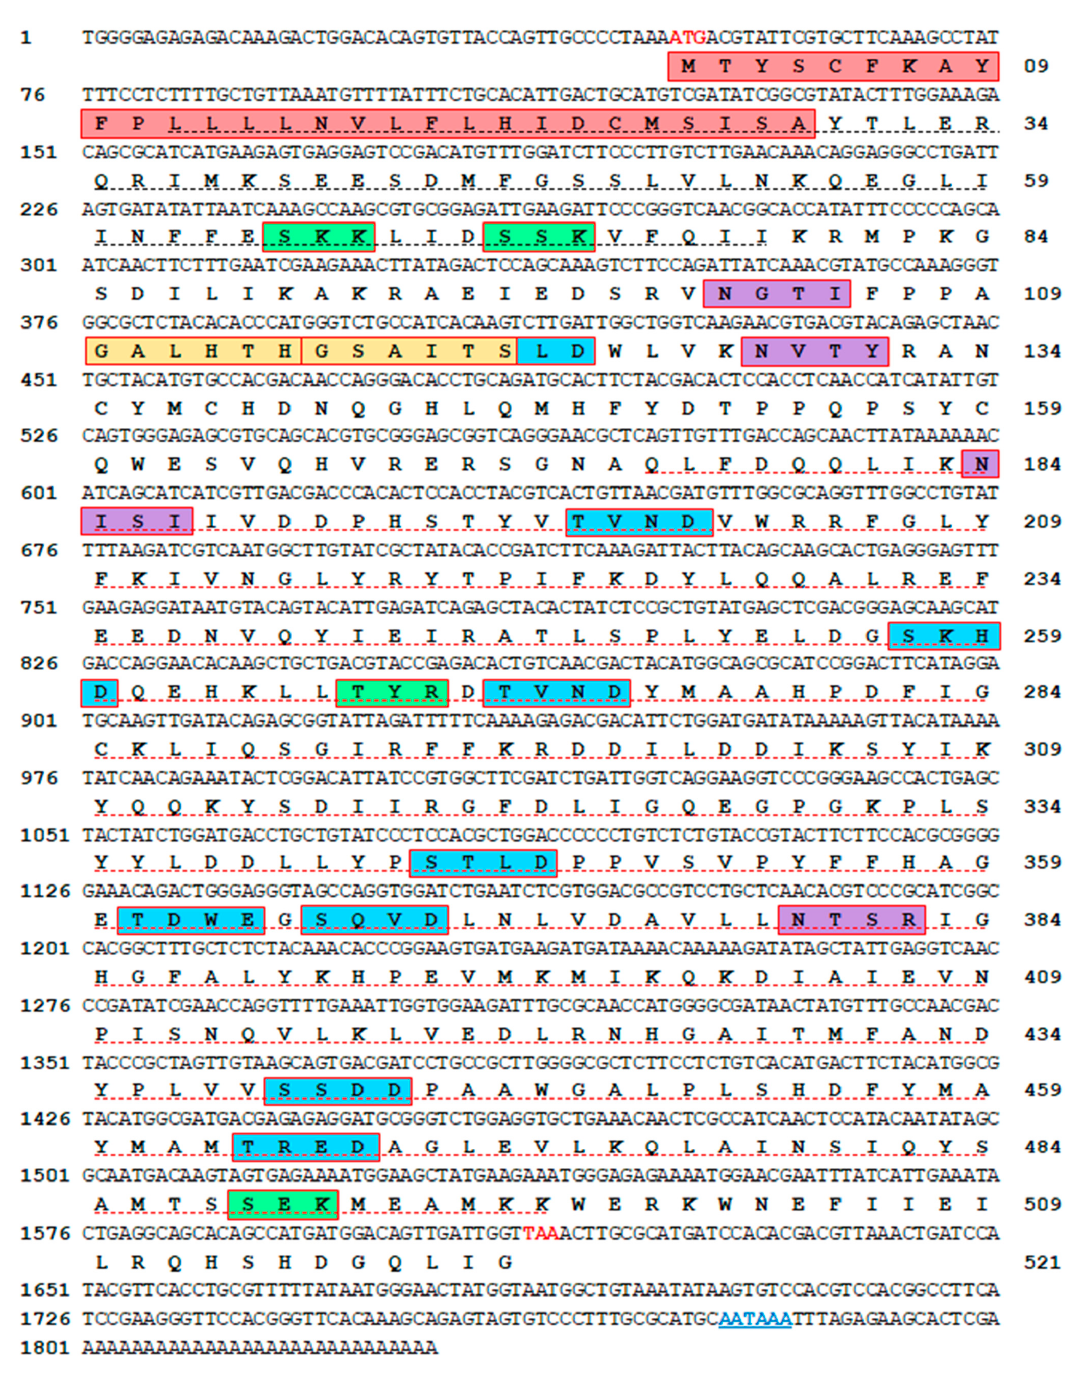
Figure 1. The Full-length nucleotide and amino acid sequences of Hdh-MLGF (GenBank accession no. ON803449). The numerical numbers at the left and right side of the sequence indicate the position of the nucleotide and amino acid sequence of the Hdh-MLGF gene, respectively. The coding regions starting with the start codon (ATG) and ending with the stop codon (TAA) are shown in red bold letters. The signal peptide for the secreted Hdh-MLGF protein has been indicated by the red box. The adenosine deaminase domain is marked with a red underline and an additional N-terminal adenosine deaminase with a black underline. N-glycosylation sites are denoted with a violet box. Potential protein kinase C (PKC) phosphorylation sites are pointed out with a green box. Predicted casein kinase II phosphorylation sites are marked with a blue box. The N-myristoylation site is boxed in yellow. The putative polyadenylation signal is denoted by a blue colored letter with a plain